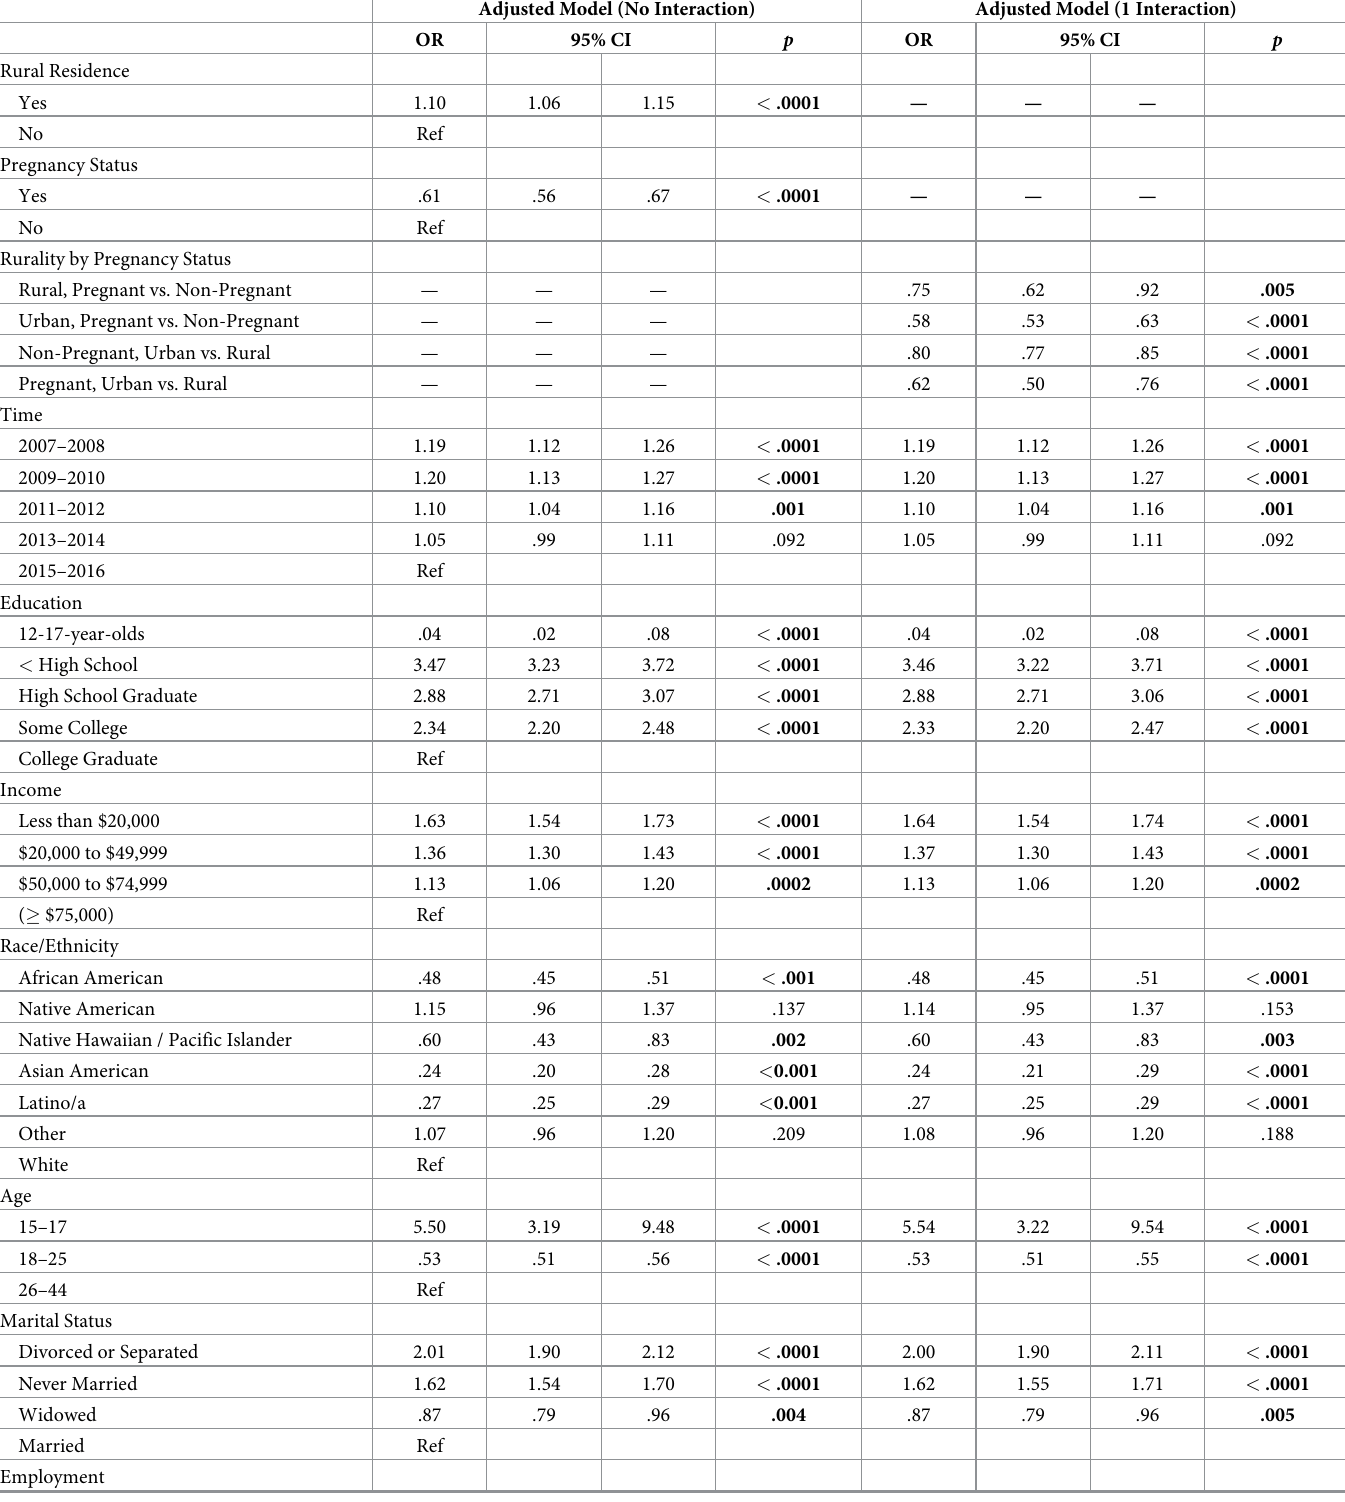
Table 2. Adjusted odds ratios (and 95% confidence intervals) from models of current smoking in the US between the years